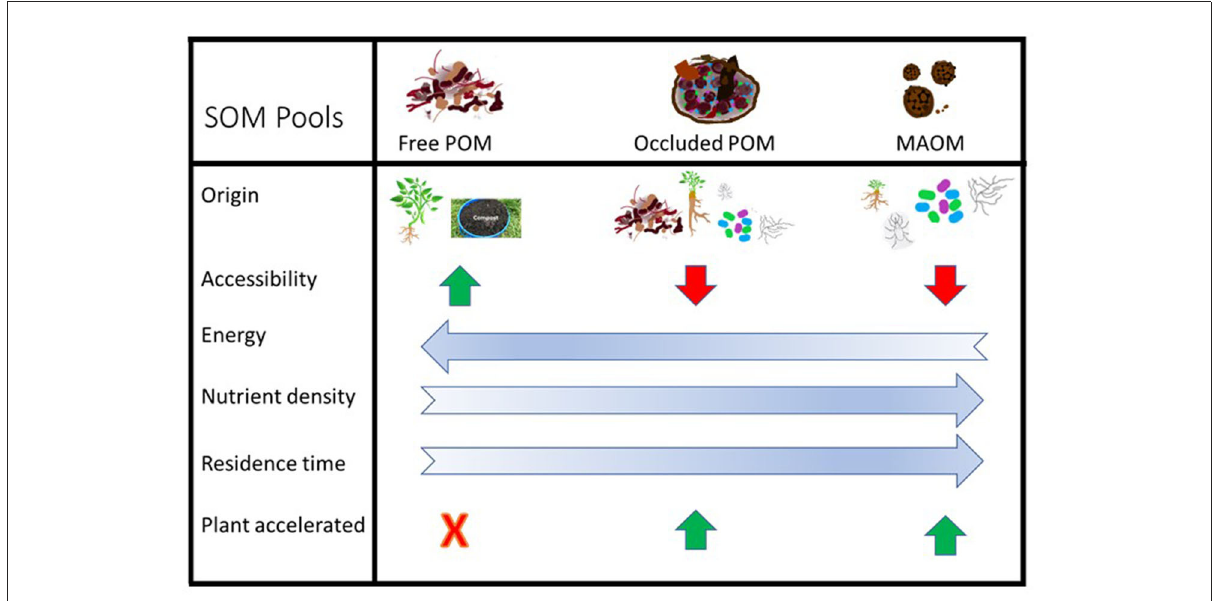
FIGURE2 Soil OM pools differ in composition and function. Compared to occluded particulate OM (POM) and mineral associated OM (MAOM), free POM is more accessible to decomposers, more energy rich but nutrient poor with a relatively fast turnover time (Liang et al., 2019; Lavallee et al., 2020). Occluded POM and MAOM are protected through their association with mineral constituents, and while they are nutrient rich, C limitation may also hinder decomposer access. As a result, plant driven priming of decomposition is most pronounced for oPOM and MAOM (Daly et al.,